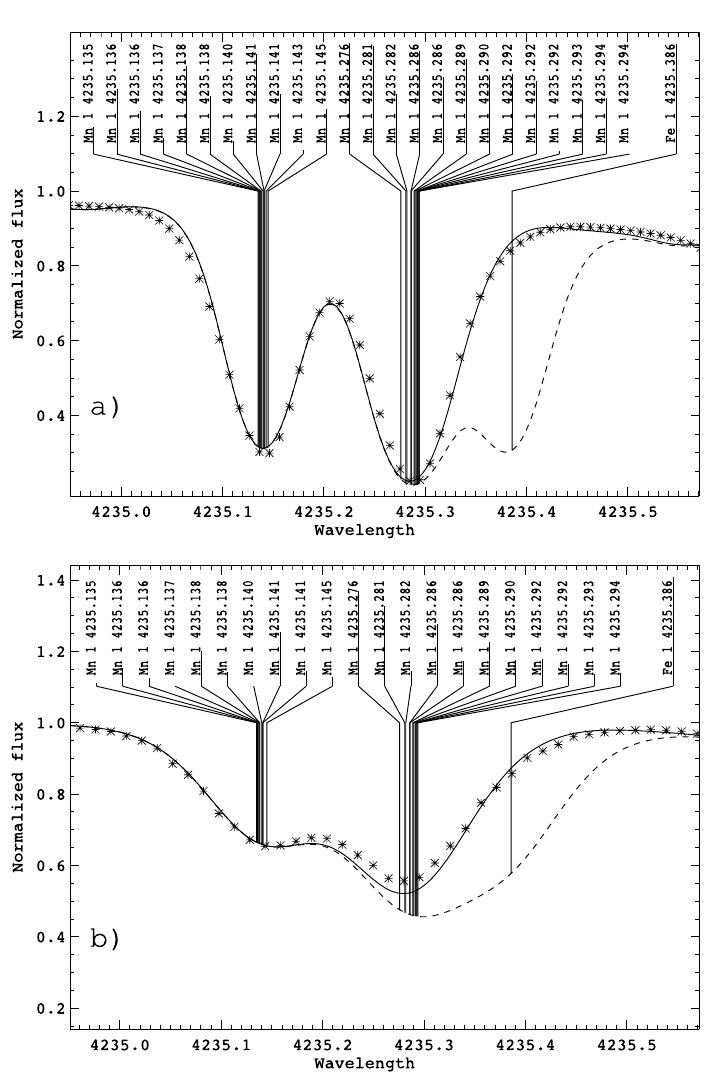
Fig. 1. Example of spectral (cid:12)tting in the region of Fe I 4235.386 (cid:23)A line for the Sun (a) and Procyon (b). Observations are plotted as asterisks; the synthetic spectrum calculated with the experimental transition probability for this line is represented by the dashed curve; the solid curve is the synthetic spectrum calculated with the theoretical transition